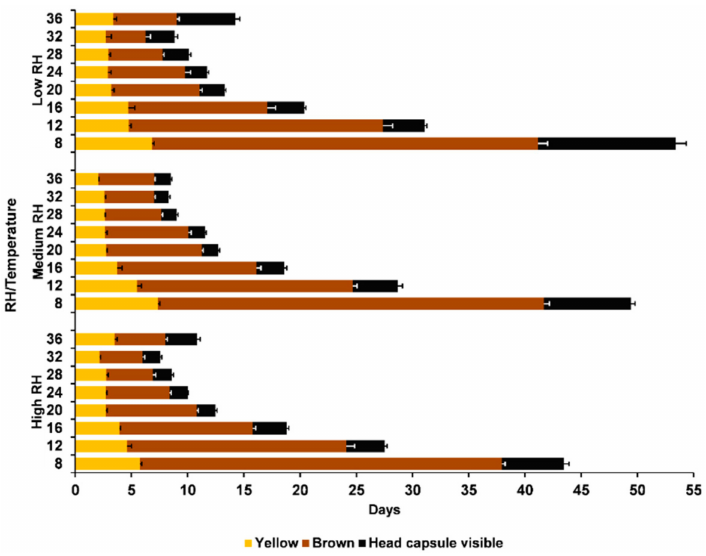
Figure 3. The external egg colour stages of the alfalfa weevil, Hypera postica , at different temperatures and relative humidity regimes (high: 90% < RH < 100%; medium: 50% < RH < 75%; and Low: 10% < RH < 35%). Yellow: early developmental stage when the egg was yellow; Brown: intermedium developmental stage when the egg was brown; and Black: end of the developmental stage when the head capsule was